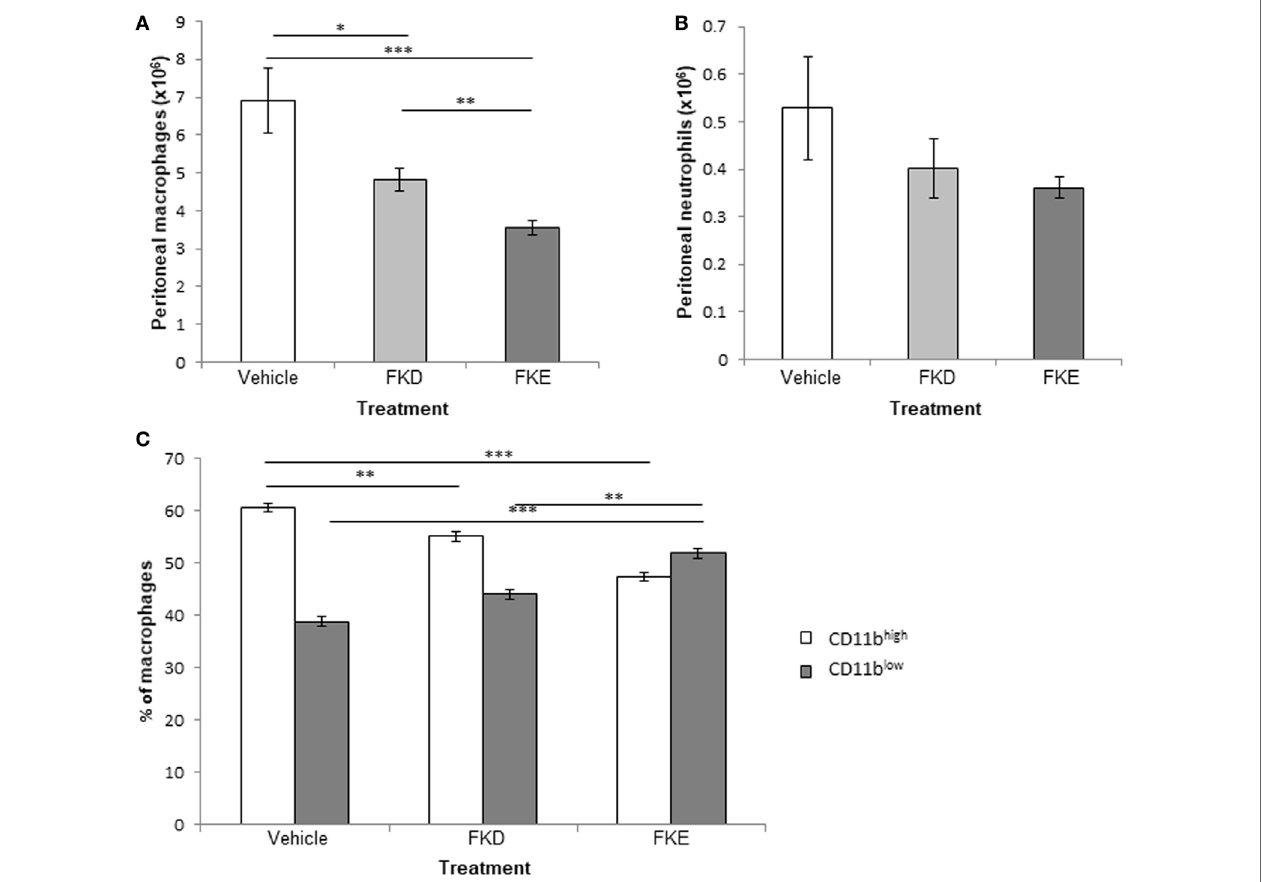
FigUre 3 | Lactoferrin (Lf)-derived peptides promote macrophage conversion to the CD11b low phenotype. Mice undergoing peritonitis for 48 h were injected intraperitoneally (i.p.) with PBS, FKE, or FKD peptides (50 µM each). After additional 18 h, peritoneal exudates were recovered and the cells were enumerated. Then, exudate cells were immunostained for Ly-6G, F4/80, and CD11b and analyzed by flow cytometry. The numbers of macrophages (a) and neutrophils (B) , and the percentages of CD11b high and CD11b low macrophages (c) are presented. Results are averages ± SEM from three independent experiments ( n = 4 per group). ***/**/*indicate statistically significant differences of P ≤ 0.005/ P ≤ 0.01/ P ≤ 0.05, respectively, by ANOVA with Tukey post hoc